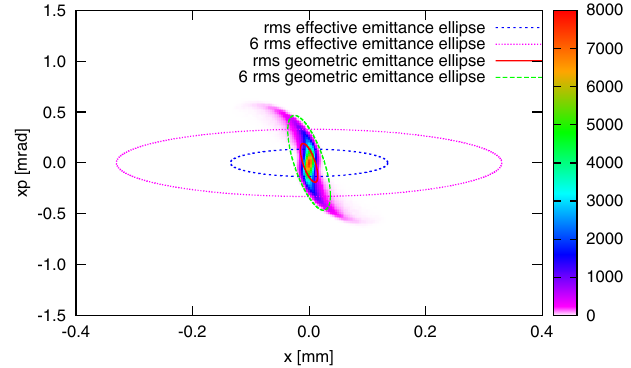
FIG. 4. (Color) Phase space distribution of the electron beam after collision for (cid:6) (cid:5) ¼ 1 m , back traced to the IP. The rms and 6 rms ellipses for both geometric and effective emittance, respec- tively, are